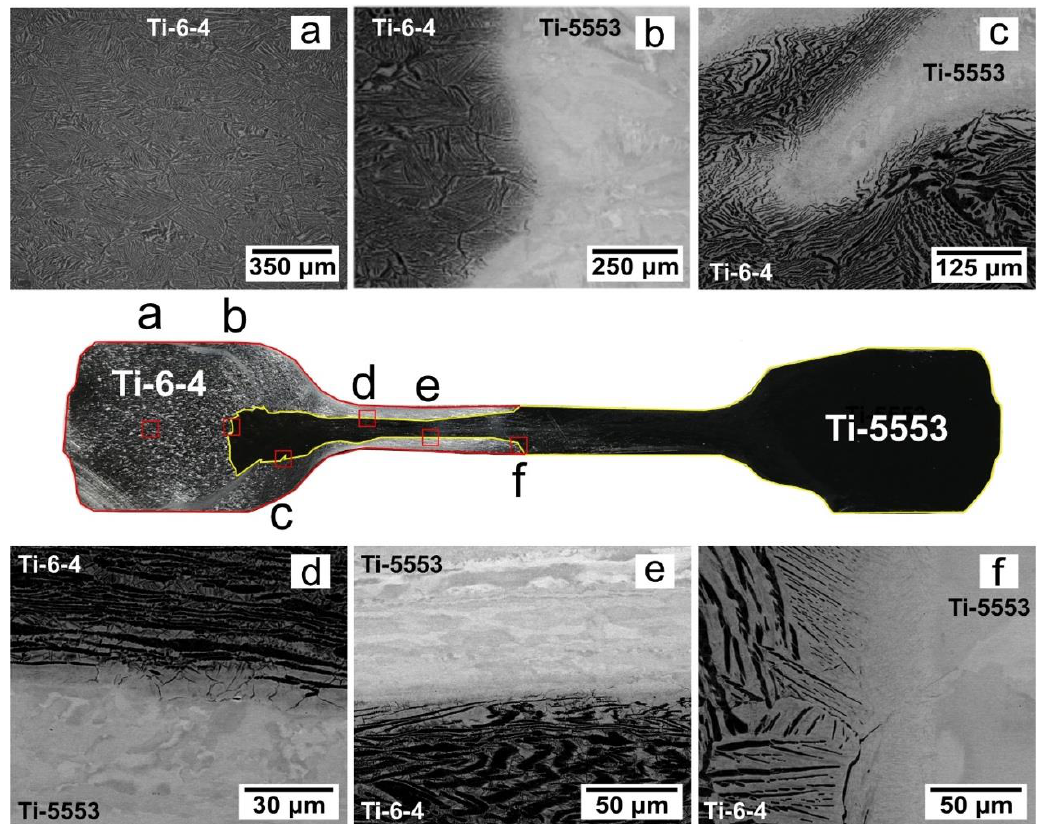
Figure 16. High-resolution backscatter micrographs of regions of interest in the high strain cross section of eye-bolt 2 (Ti-5553 with Ti-6-4); ( a ) bulk Ti-6-4 microstructure in the side section; ( b ) bond interface in a relatively low strain location; ( c ) and an example of a wavy interface; ( d ) high-strain bond interface on the upper side of the thin section; ( e ) the high-strain bond interface on the lower side of the thin section; and ( f ) the bond interface at the middle of the eye-bolt.